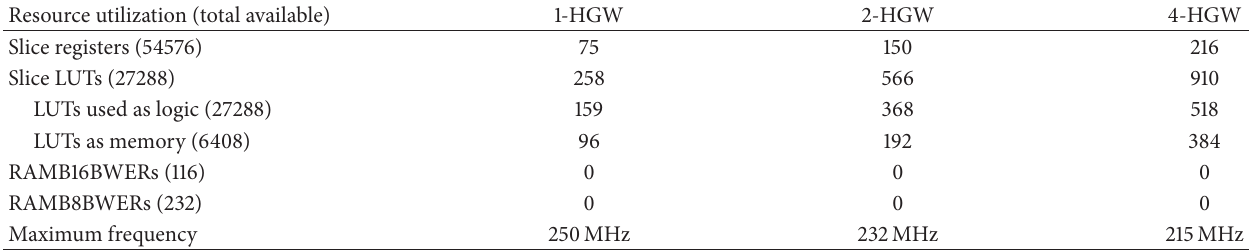
Figure 6: Examples of 1024×1024 test images used to validate the architecture functionality. ((a) and (d)) the input images and (b) max filter by 21 × 21 , (c) max filter by 63 × 63 , (e) min filter by 21 × 21 , and (f) min filter by 63 × 63 . Table 1: Summary of the hardware resource utilization for the proposed architecture targeted to a Xilinx Spartan-6 LX45 device for different number of instances of the HGW